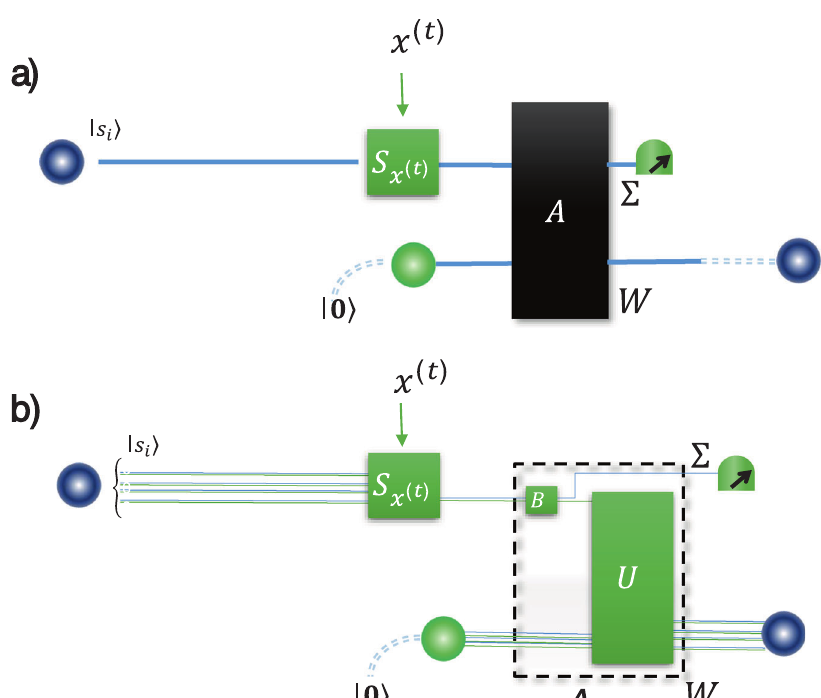
Fig. 5 a The process by which the quantum transducer generates future statistics as outlined in Fig. 3. b A more detailed breakdown of. Upon input x at time t , the transducer fi rst applies the selection operator S x . The subsequent operator A can be decomposed into two operators, a (cid:4) (cid:5) (cid:7) (cid:4) P (cid:4) (cid:4) s x T y j x y j i τ k j i y h j τ k h j , and a decompression operator U that rotates each τ k j i into | s k 〉 (always possible when linear mapping B : s x ! i i y ; k ik suitable ancillary systems in states | 0 〉 are supplied). Σ is emitted as output, while W is retained as the subsequent causal state at time t . This circuit makes it clear that τ k j i also make perfectly valid causal